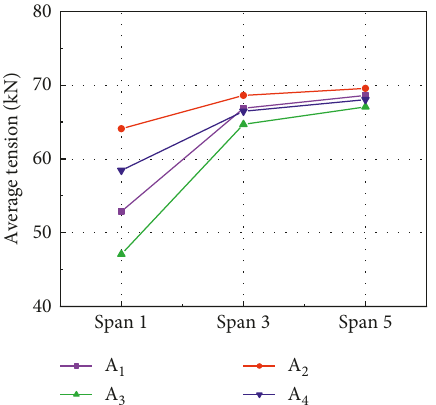
Figure 16: Relationship between span number and average tension of conductor hanging